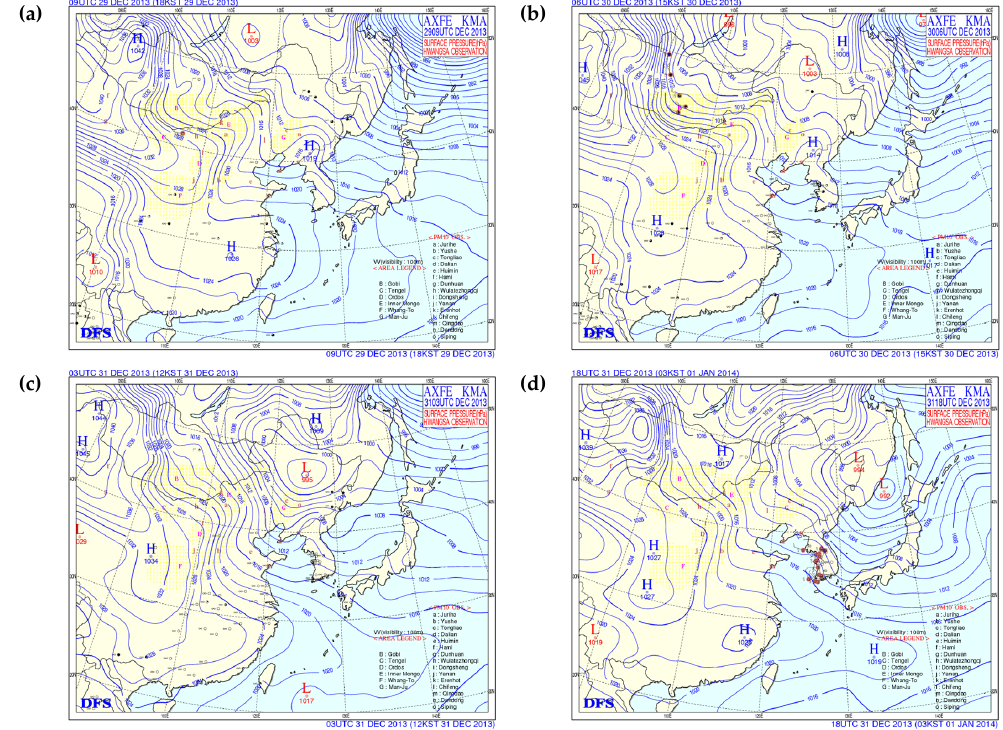
Figure 1. Surface weather chart for ( a ) 29 December 2013 at 18:00 KST, ( b ) 30 December 2013 at 15:00 KST, ( c ) 31 December 2013 at 12:00 KST, and ( d ) 1 January 2014 at 03:00 KST.